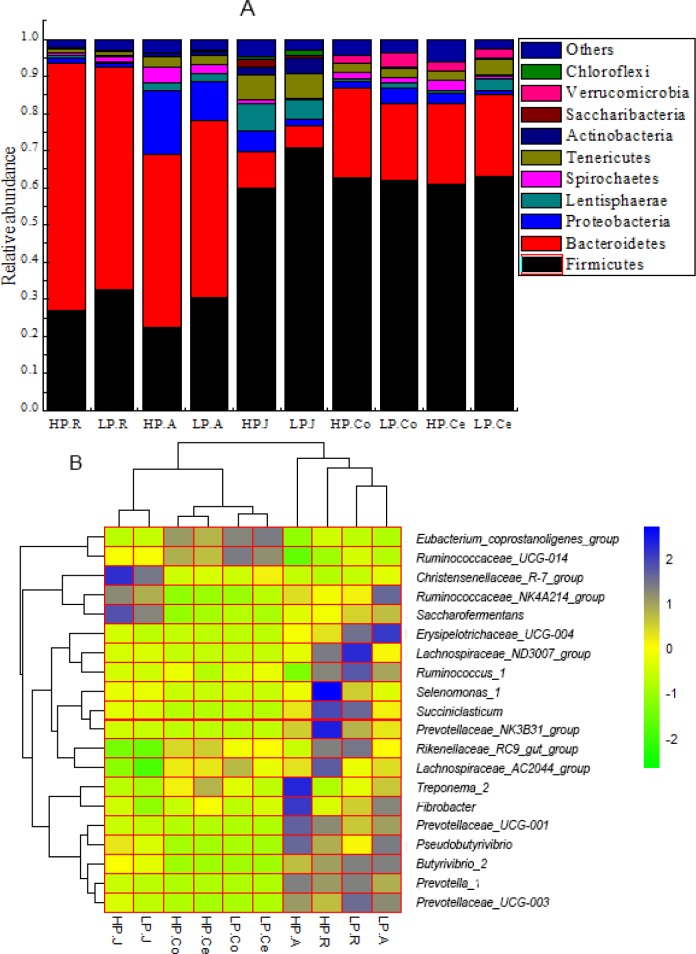
A: Bacterial compositions across the gastrointestinal tract at the phylum level (only the top 10 abundant phyla are presented). HP.R: rumen of HP; LP.R: rumen of LP; HP.A: abomasum of HP; LP.A: abomasum of LP; HP.J: jejunum of HP; LP.J: jejunum of LP; HP.Co: colon of HP; LP.Co: colon of LP; HP.Ce: cecum of HP; LP.Ce: cecum of LP. B: Heatmap of the core genera across the gastrointestinal tract (the relative abundance of microbes was log-transformed, and only the top 20 abundant genera are presented). The closer to the color blue, the higher the relative abundance, while the closer to the color green, the lower the relative abundance.